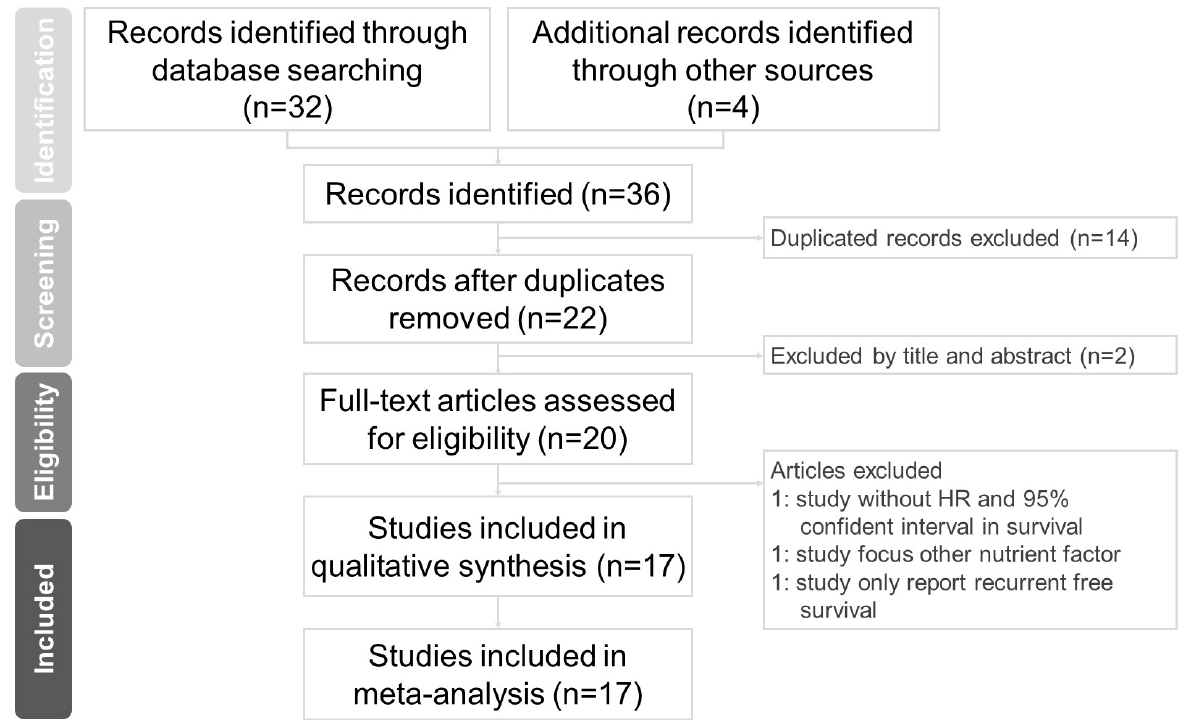
Figure 1. Flowchart of study selection.